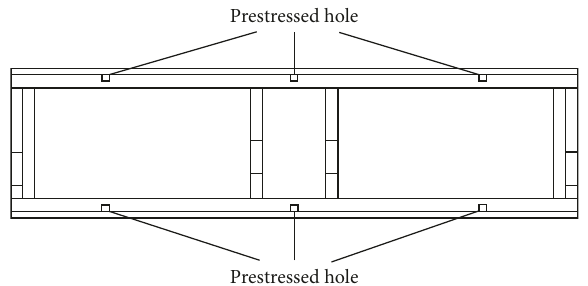
Figure 12: Schematic diagram of the prestress layout.